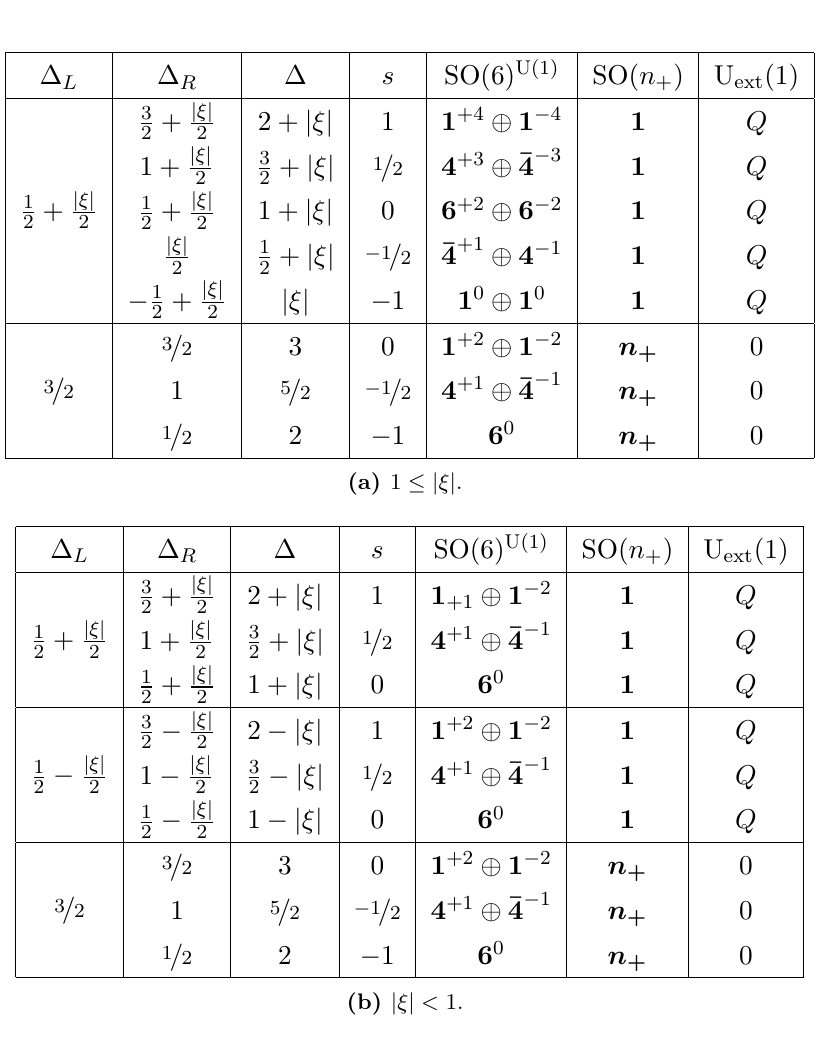
1 ; 1) solutions for chiral embedding (2.21b) with (cid:18) = 0 j MNPQ 6 SO(2 ; 1) for (cid:24) = 1 and SO(6 ; n + ) SO(2 ; 2) otherwise. (cid:2) j j (cid:2) = 2 (cid:21) there 6